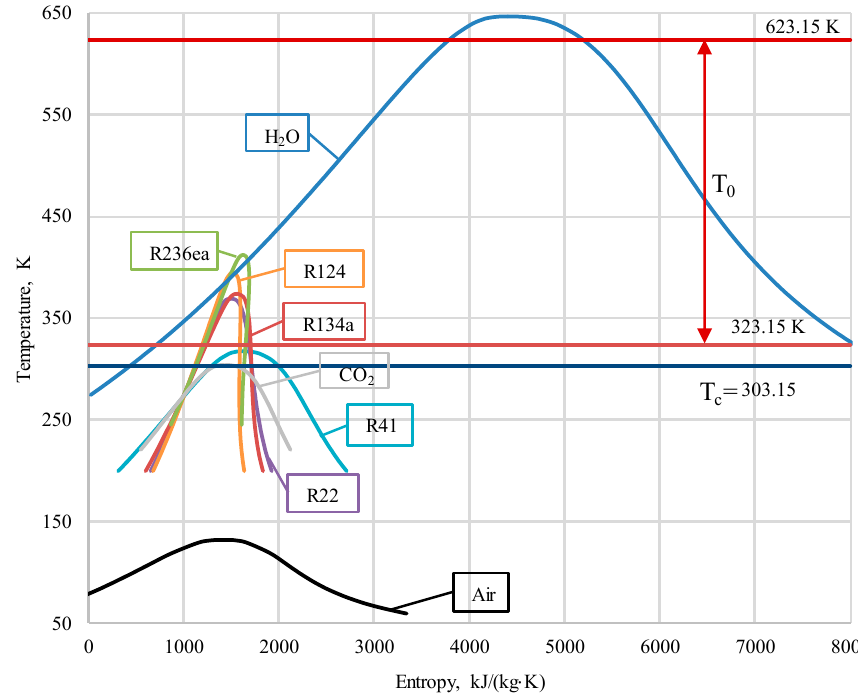
Figure 3. TS diagram of different working fluids.